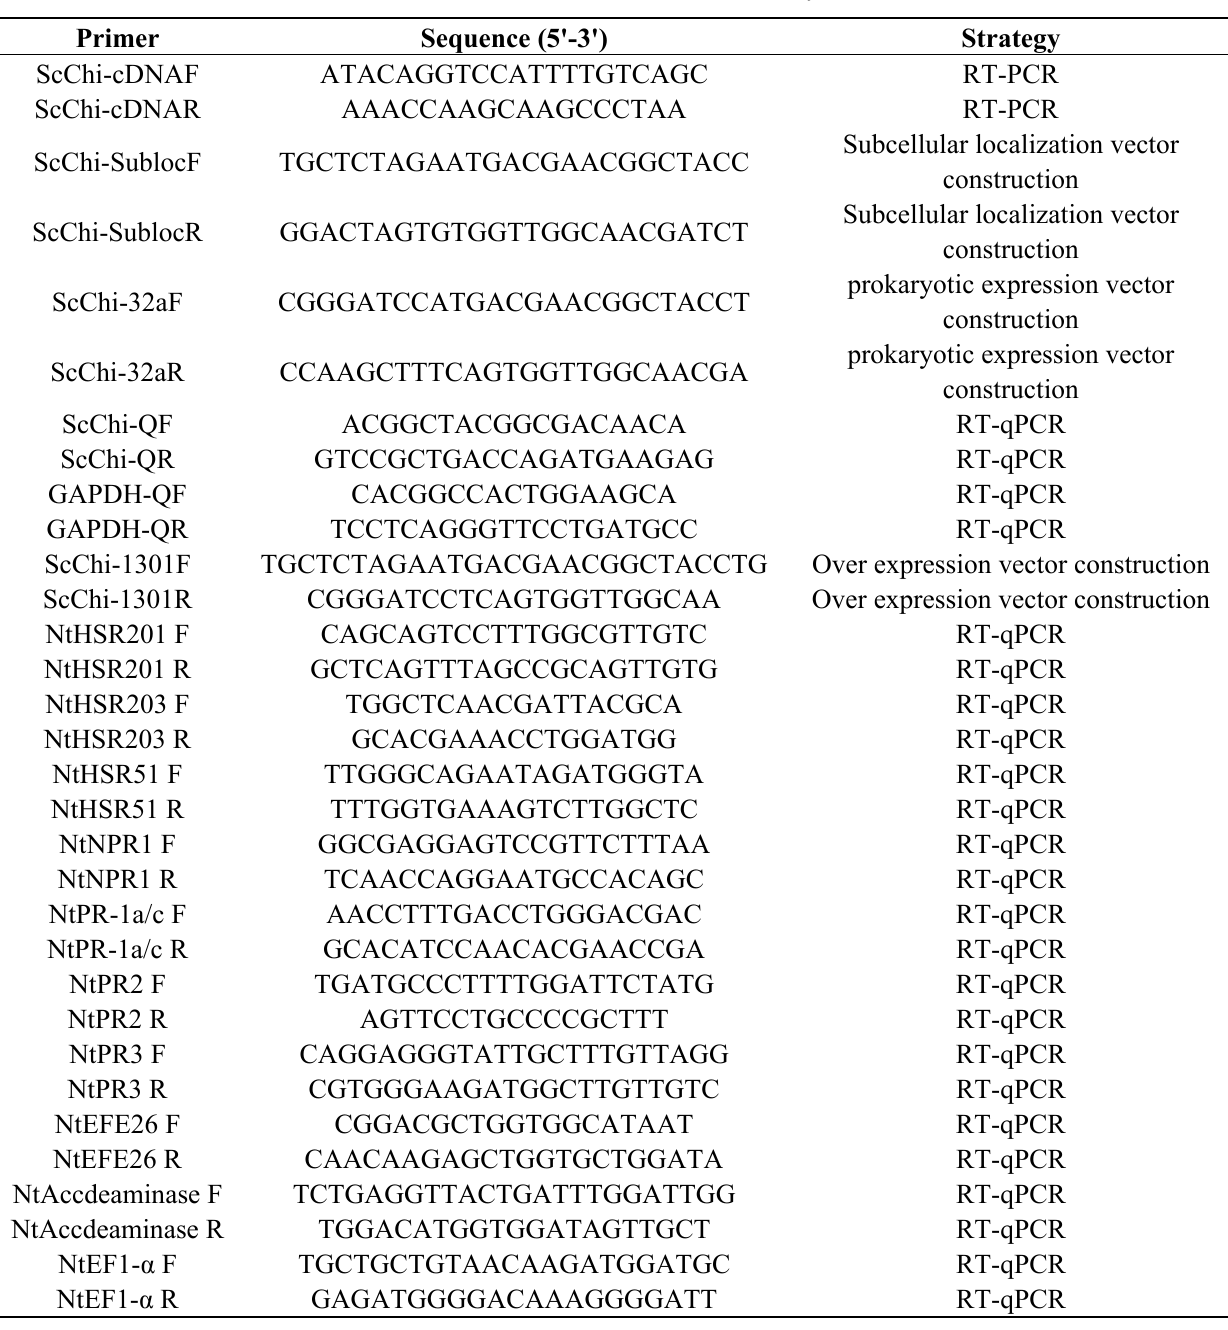
Table 1. Primers used in this